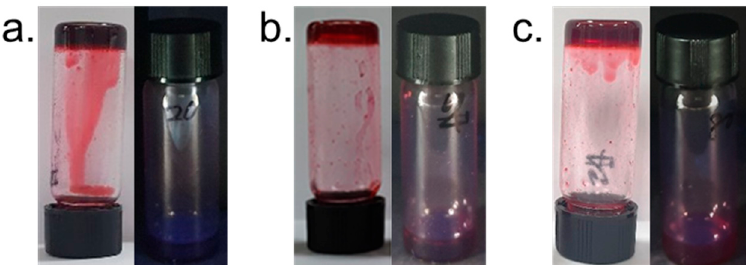
Figure 2. Photograph of co-assembled supramolecular gel dependent on the ratio of compound 2 in DMSO (1 wt %, with respect to 1 ); [ 2 ] / [ 1 ] = ( a ) 0.2, ( b ) 0.5 and ( c ) 0.8.